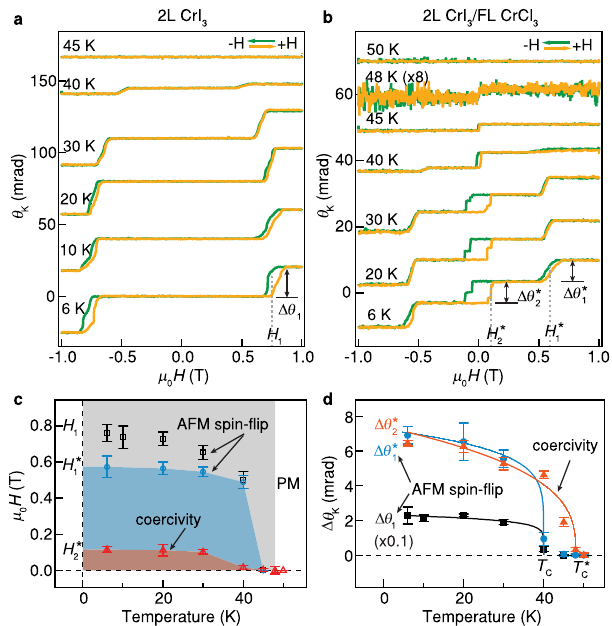
Fig. 2 | Temperature dependence of the magnetism of 2L CrI 3 and 2L CrI 3 /FL CrCl 3 heterostructure. MOKE signal in the 2L CrI 3 region ( a ) and the 2L CrI 3 /FL CrCl 3 heterostructure region ( b ) as a function of perpendicular magnetic fi eld at different temperatures. Critical fi elds H 1 , H 1 * , H 2 * and magnitudes in the change of MOKE signal Δ θ 1 , Δ θ 1 * , Δ θ 2 * of magnetic transitions are labeled. c Temperature dependence of the critical fi elds of magnetic transitions. PM paramagnetic. The critical fi elds are extracted from the peak of derivative d θ K /d H and the error bars are the peak widths. d Temperature dependence of the magnitudes in the change of MOKE signal at magnetic transitions. Solid curves are fi tted by a power-law equation 11 .Thecriticaltemperatures T C and T C * areindicated.Theerrorbarsarethe uncertainties in extracting the transition